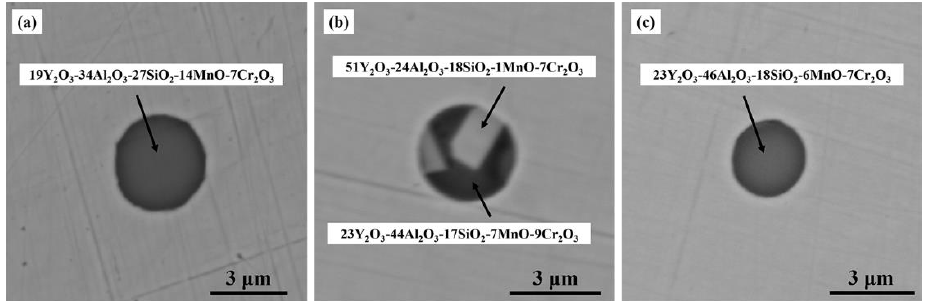
Figure 1. Typical inclusions in as-cast steel #1 ( a ) and #2 ( b , c ).